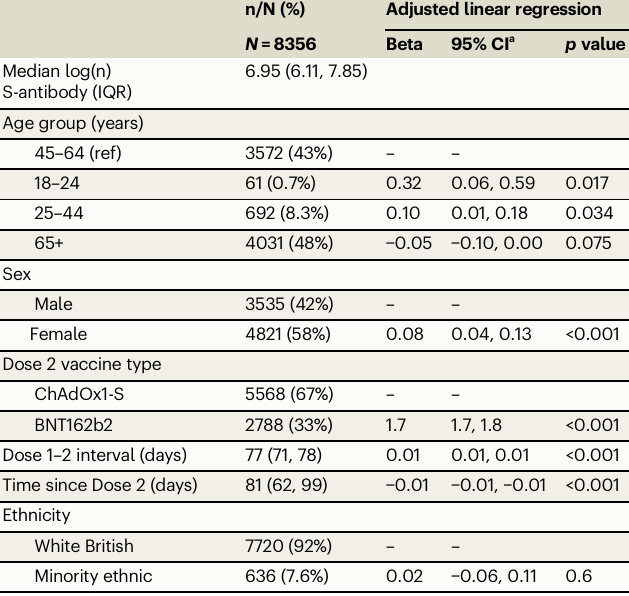
Table 3 | Beta coef fi cients, 95% con fi dence intervals, and associated unadjusted p values (from two-tailed t -tests) derived from a single multivariable linear regression model of demographic and vaccination factors associated with log(n) Spike-antibody levels at ≥ 28 days after Dose 2. These cov- ariates were subsequently included in the adjusted linear regression models examining the association between each clinical risk factor and log(n) Spike-antibody levels at ≥ 28 days after receiving Dose